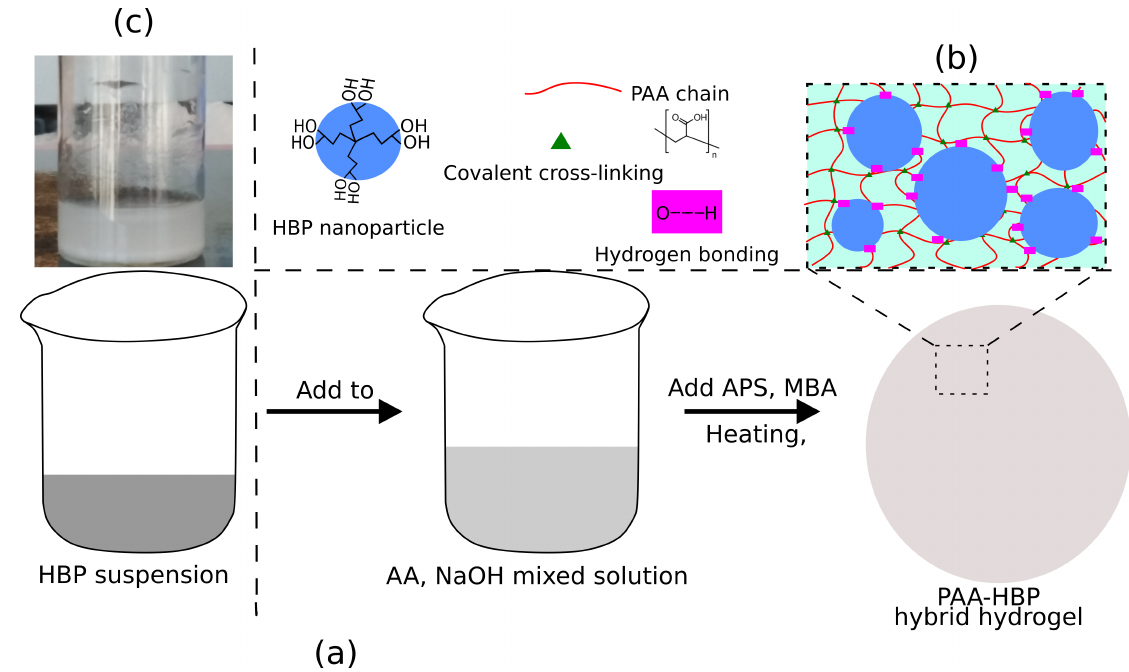
Figure 2. Schematic protocol for preparation of the hybrid hydrogel of PAA and HBP. ( a ) Facile preparation procedure. ( b ) Chemical and physical cross-linking inside the polymer network. ( c ) Photograph of HBP3 solution (0.05 g cm − 3 ), forming a colloidal